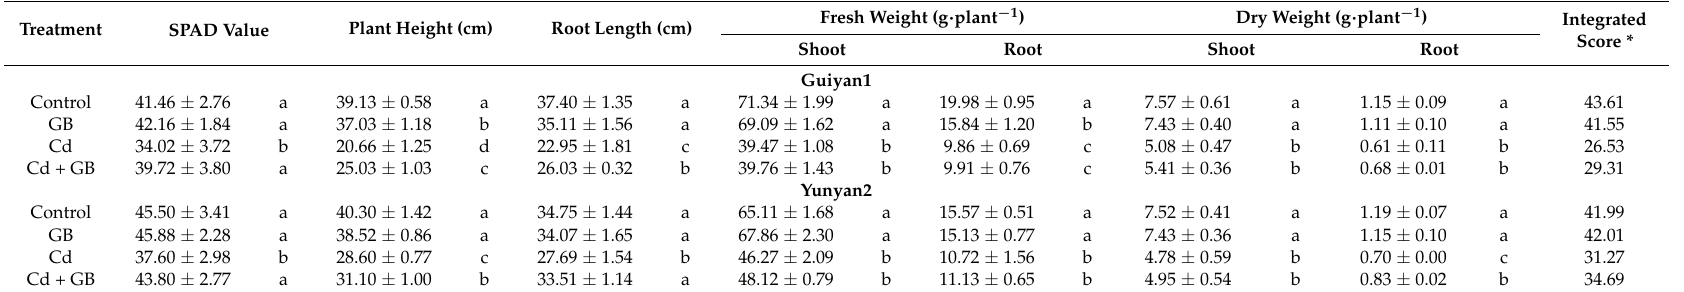
The data were the means of three independent replicates. The different letters in each column indicate the significant differences ( p < 0.05) among the 4 treatments within each cultivar. Control, GB (glycinebetaine), Cd, and Cd + GB correspond to the basic nutrition solution (BNS) + foliar spray of deionized water, BNS + foliar spray of 500 µ M GB, BNS + foliar spray